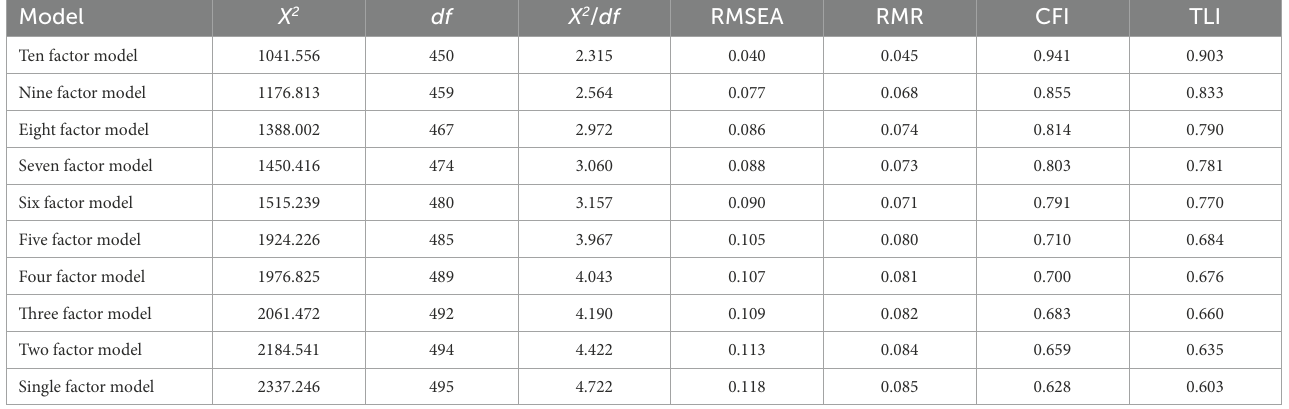
TABLE 3 Results of the confirmatory factor analysis ( n = 268).